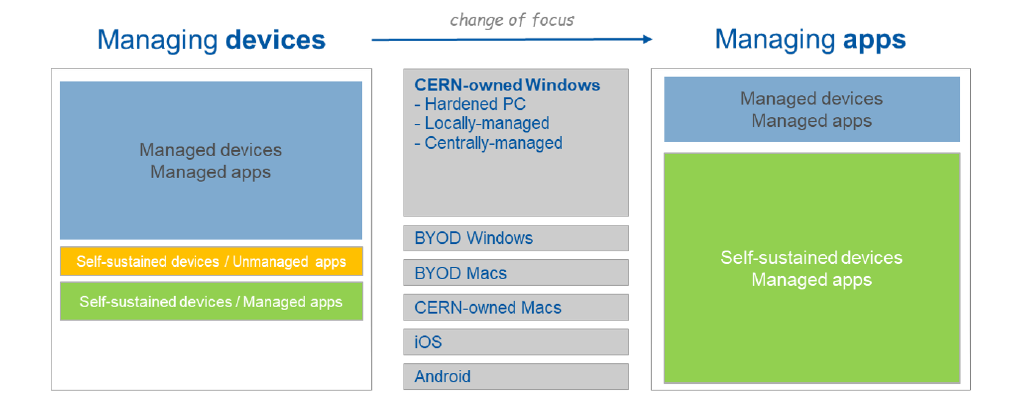
Figure 1. Shift in the device management